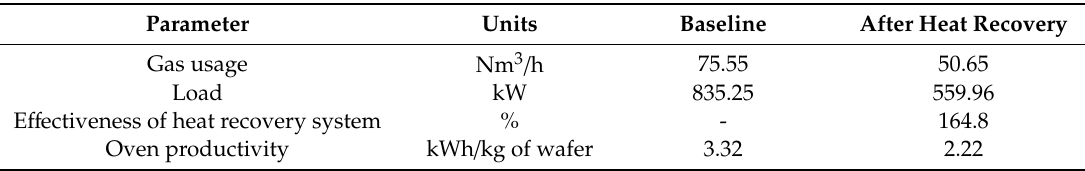
Table 10. Key performance indicators of the industrial-scale baking oven before and after heat recovery to preheat combustion air of five ovens.